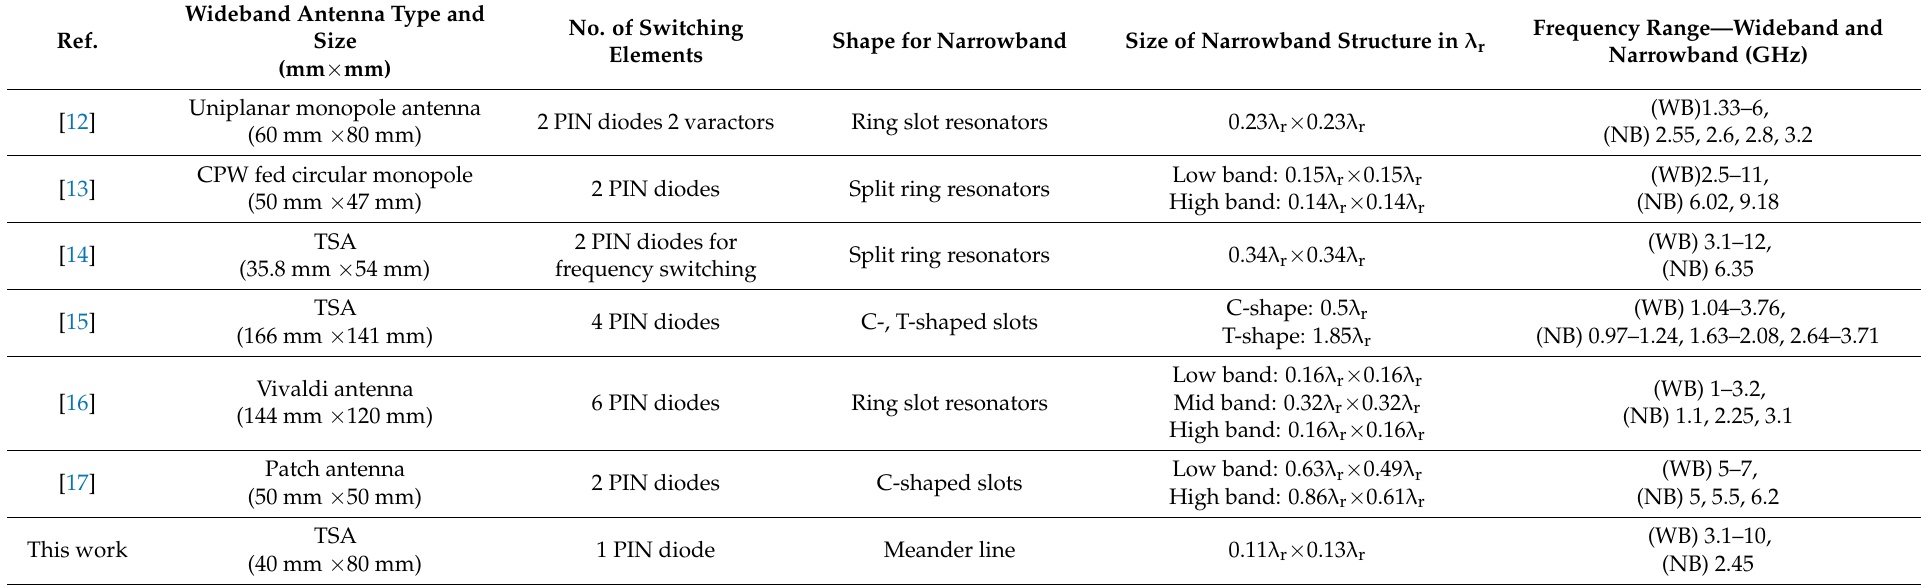
Table 2. Comparison with existing